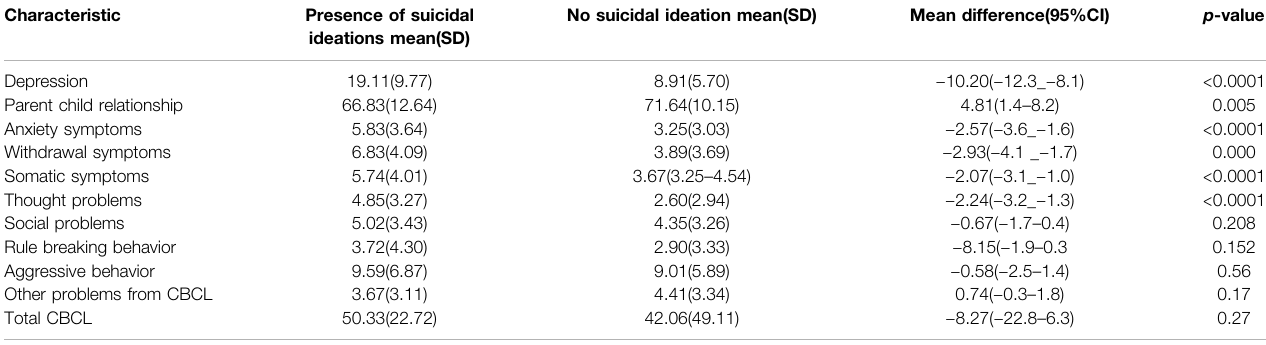
TABLE 3 | Factors associated with suicidal ideations (Depression, Emotional andBehavioral problems and Parent Child relationship) at Bivariate analysis. Characteristic